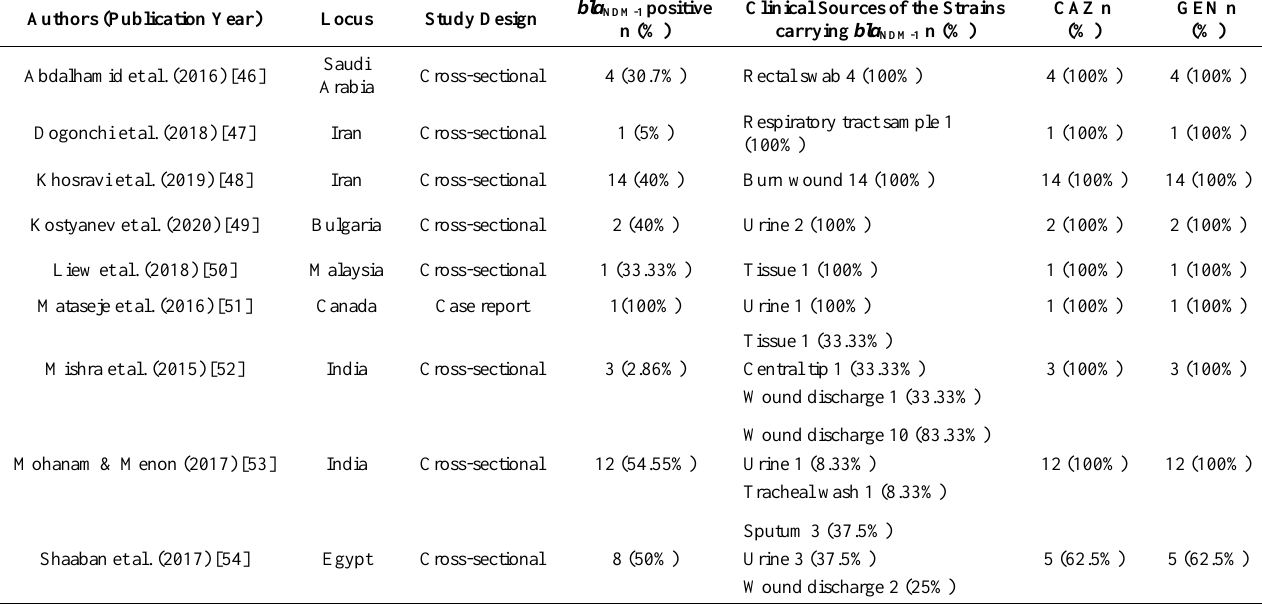
Table 1. Summary of the extracted data from the included studies